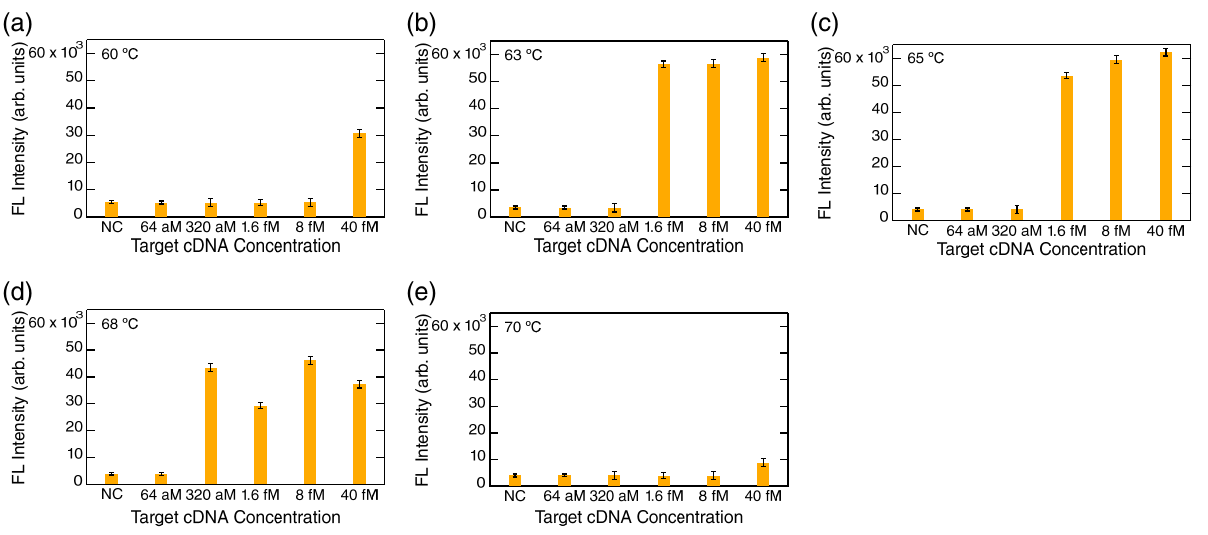
Figure 3. FL detection after LAMP at various reaction temperatures: ( a ) 60 ◦ C. ( b ) 63 ◦ C. ( c ) 65 ◦ C. ( d ) 68 ◦ C. ( e ) 70 ◦ C. The reaction time was fixed at 60 min in these five conditions. Measured FL intensities are shown with error bars. NC denotes negative control, meaning 0 molar (M) target in the Tris-HCl buffer for